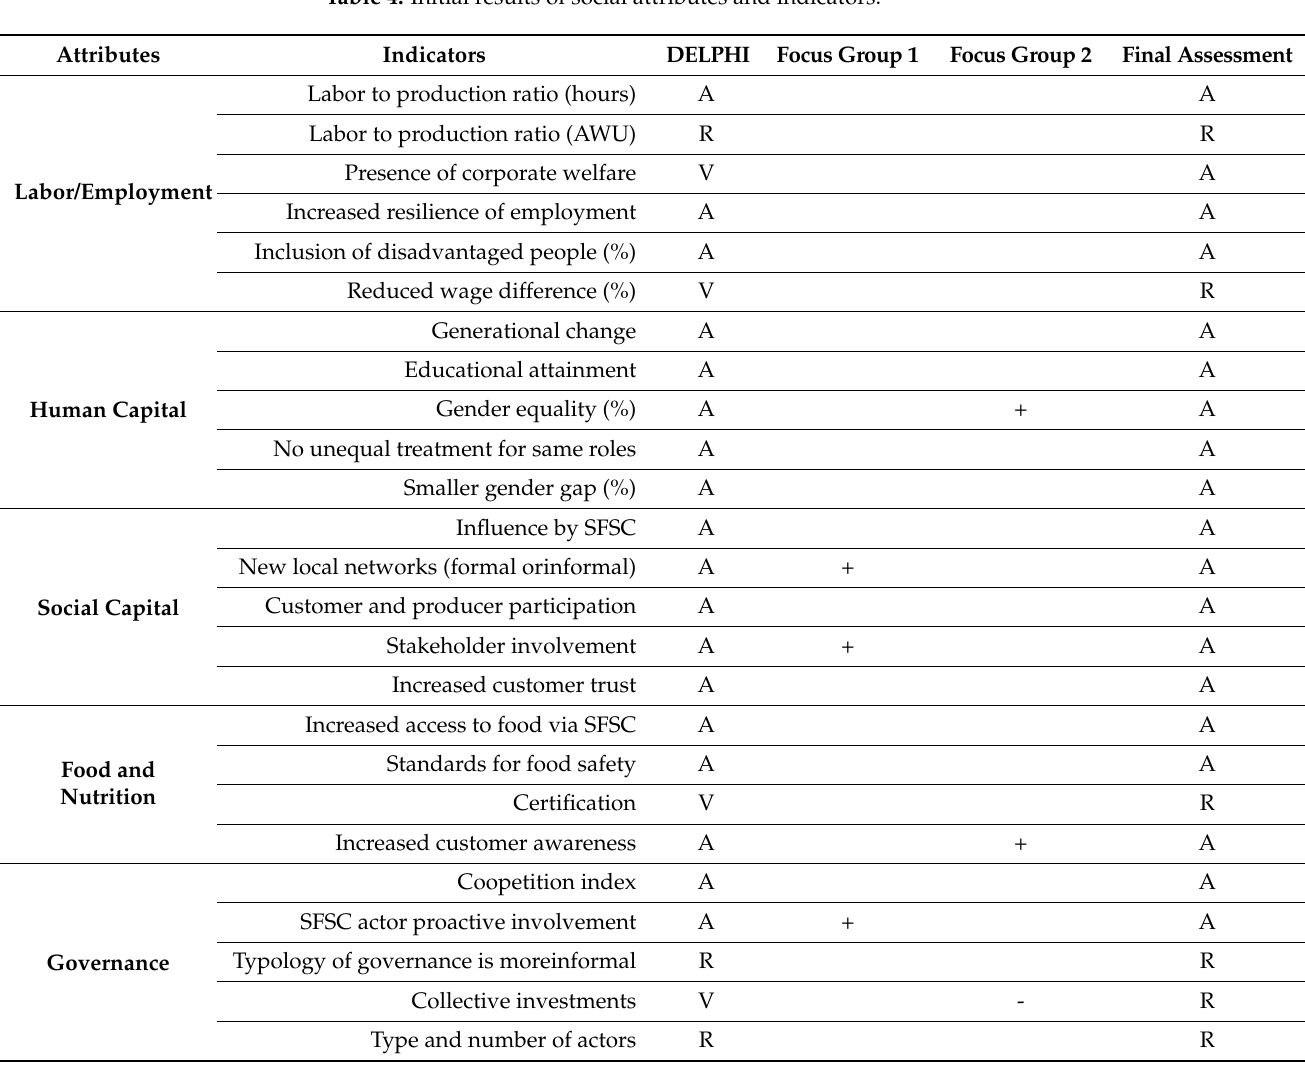
Table 4. Initial results of social attributes and